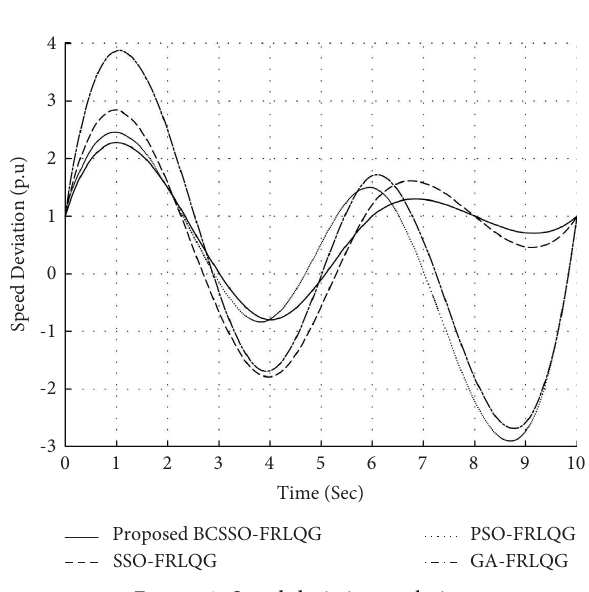
Figure 8: Speed deviation